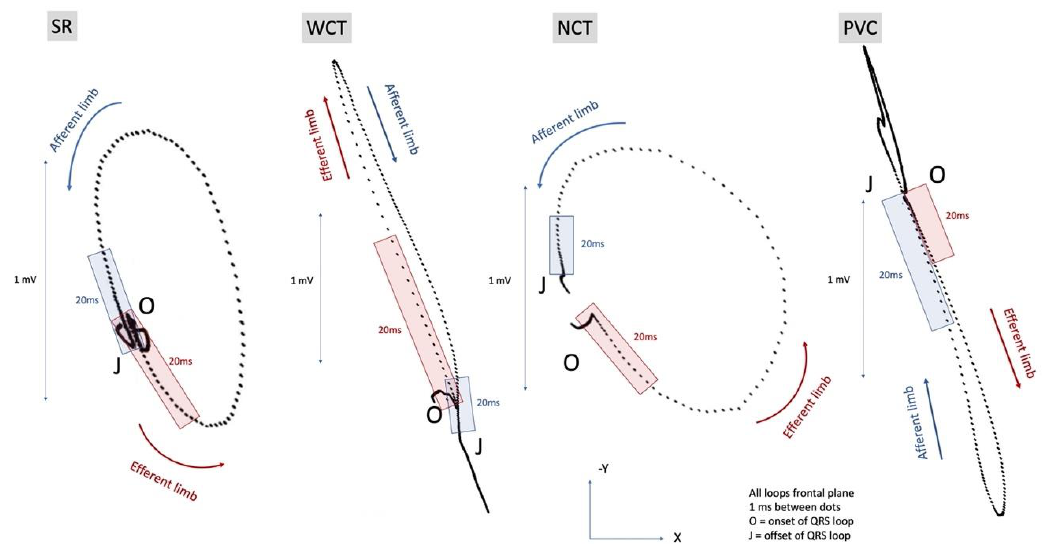
Figure 4. Vectocardiographic QRS loops in the frontal plane during sinus rhythm (SR), wide complex tachycardia (WCT), narrow complex tachycardia (NCT), and ventricular premature contraction (PVC). These are the beats displayed with an asterisk in Figure 2. The distance between black markers corresponds to 1 ms. The timing and sequence of ventricular activation at baseline (sinus beats with nar- row QRS) showed similar velocities of activation during the efferent and the afferent limbs. During NCT, ventricular activation showed a similar pattern, albeit slightly faster during the initial 20 ms than during the terminal 20 ms. During WCT, ventricular activa- tion in the initial portion of the efferent limb was significantly faster (more widely dis- tanced 1 ms markers) than in the afferent limb. This contrasted with the slow initial acti- vation (closely spaced 1 ms markers) seen during the PVC. The fast initial activation seen in the efferent limb of the QRS loop during the WCT was thought to be reflective of the fast initial activation via the conduction system seen in SVT with aberrancy, which was our final diagnosis for the WCT episode. 2.2. Management The patient was treated for heart failure with reduced ejection fraction according to the current guidelines, with a combination of a betablocker, an ACE inhibitor, a mineral- ocorticoid antagonist, and a loop diuretic. On this regimen, the patient improved clinically and, at her 12-month follow-up visit, reported no interval hospitalizations. There were no further WCT episodes during Holter monitoring, and the echocardiogram revealed an improvement in the LV ejection fraction to 48%. 3. Discussion Demonstrated here as a case of a patient newly diagnosed with LVNC, who devel- oped wide complex tachycardia with LBBB-like morphology and a superior axis. The di- agnosis wzs made using the Brugada and Vereckei algorithms, as well as by analyzing the mode of onset of tachycardia. We also described a novel approach to delineate differences in ventricular activation velocity by VCG analysis, which confirmed the diagnosis of SVT with aberrant conduction.